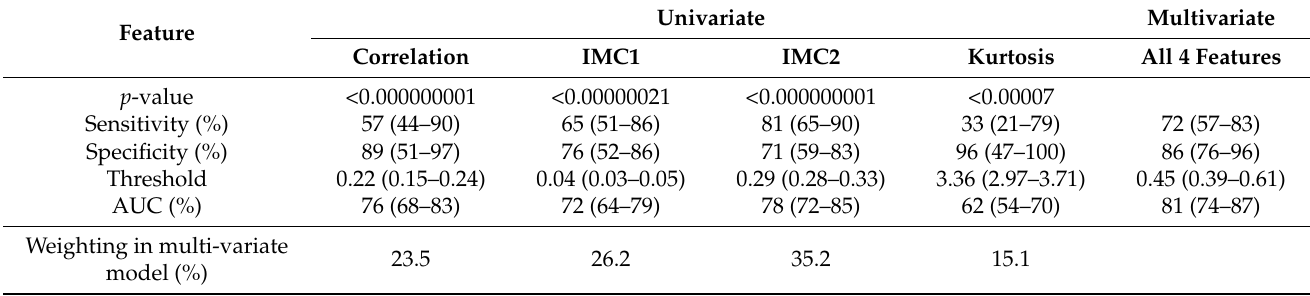
Table 2. Predictive scores with 95% confidence interval for all univariate models and the multivariate model with all four radiomic features (correlation, IMC1, IMC2, kurtosis). IMC1 and IMC2 (informational measure of correlation 1 and 2) and correlation represent texture features, whereas kurtosis is a representative of the first-order features. AUC—area under curve, IMC—informational measure of correlation. p -values were calculated using